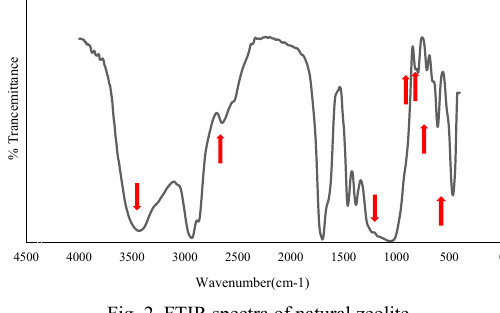
Fig. 1. XRD analysis of natural zeolite. Fig. 2. FTIR spectra of natural zeolite